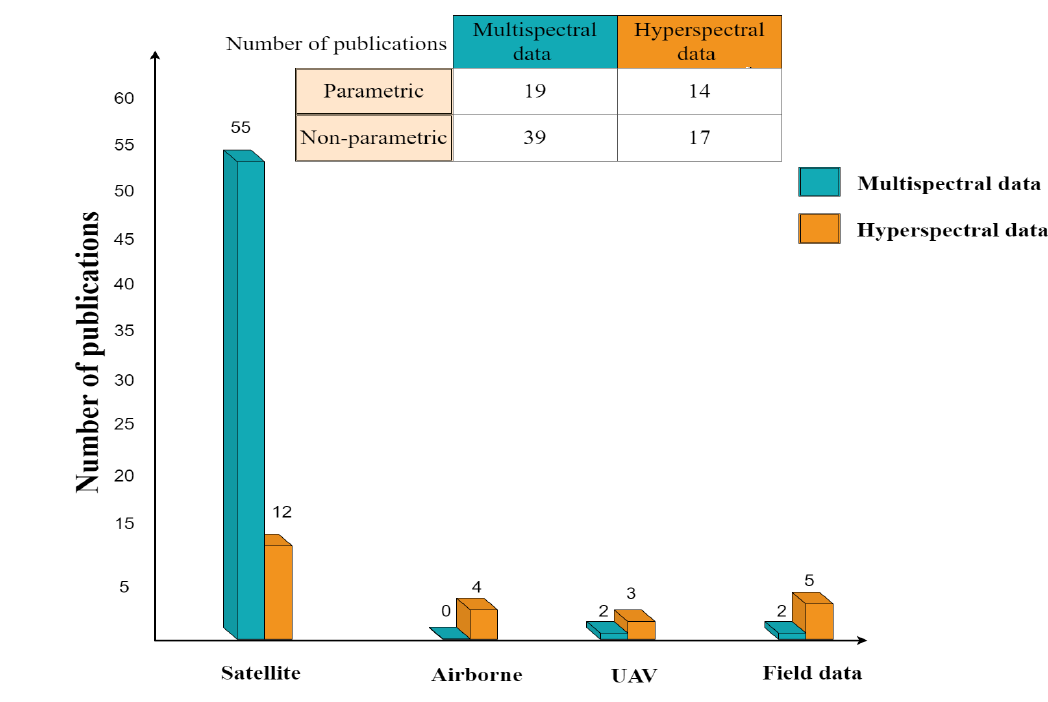
Figure 10. Sensor type used in both categories of hybrid